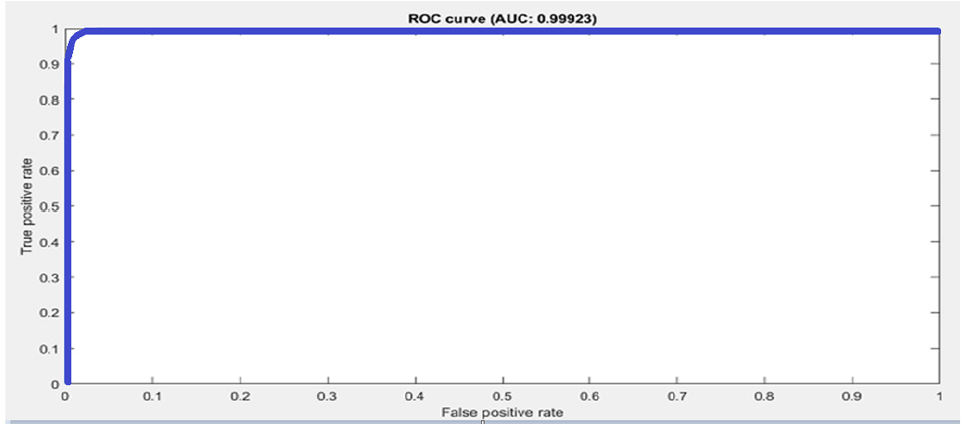
Figure 4. Macro average ROC curve and AUC score by the proposed approach using the Kaggle dataset.